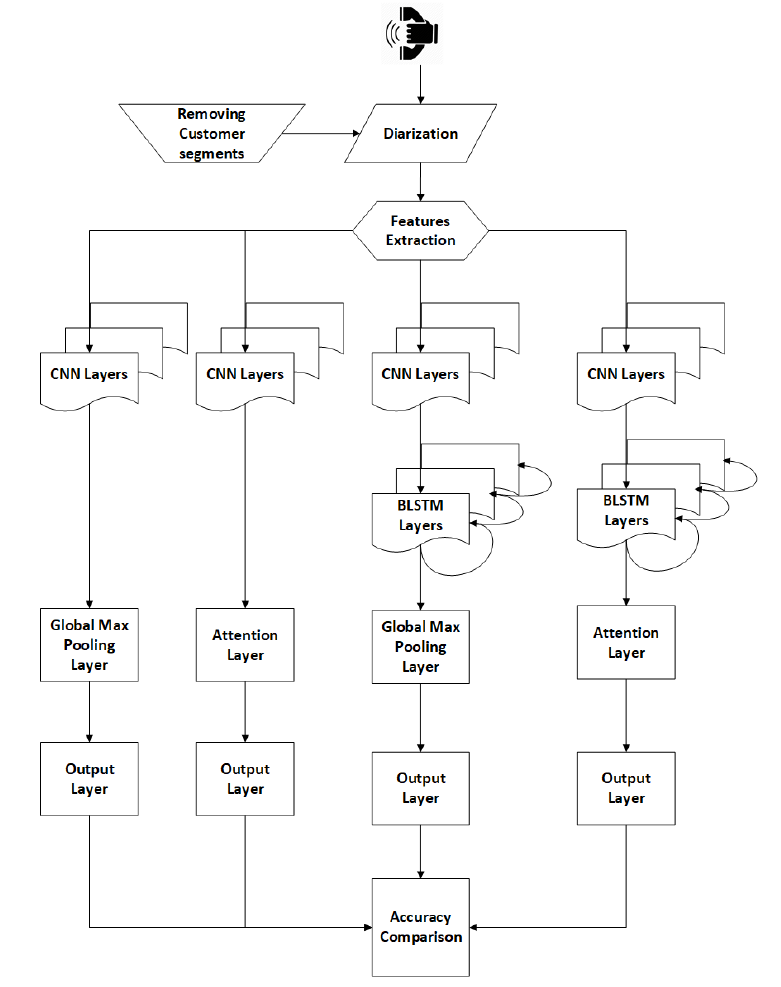
Figure 1. The proposed